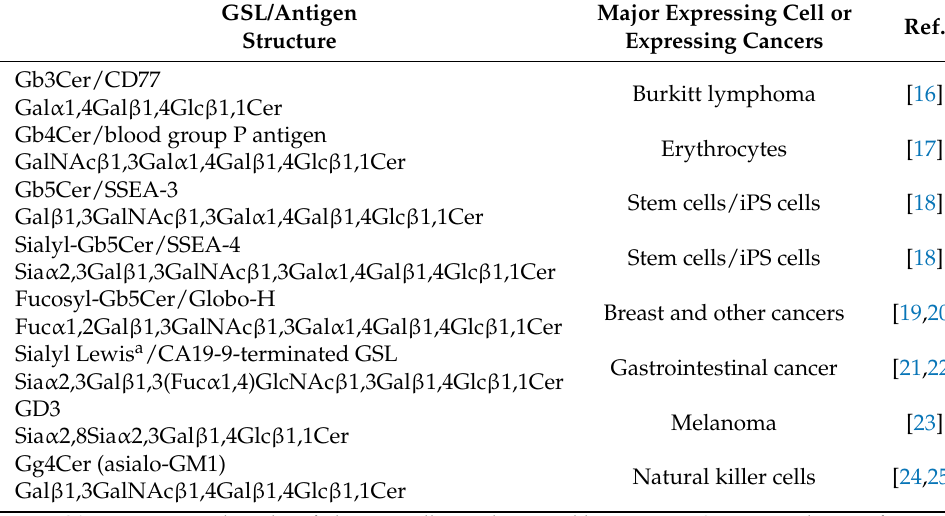
Table 1. Glycosphingolipid (GSL) markers useful for cell